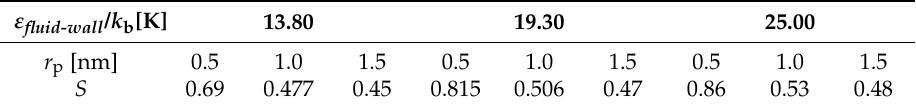
Figure 6. Nematic order parameter, S , as a function of the system pressure for the rigid linear morphology. From left to right, the energy of the fluid–solid interaction is increasing. Error bars are of the size of the symbols. Table 2. Nematic order parameter, S , for the adsorbed liquid phase for different pore sizes ( r p ) and different values of fluid–solid energy interaction ( ε fluid-wall / k b ). Values are averages taken at high